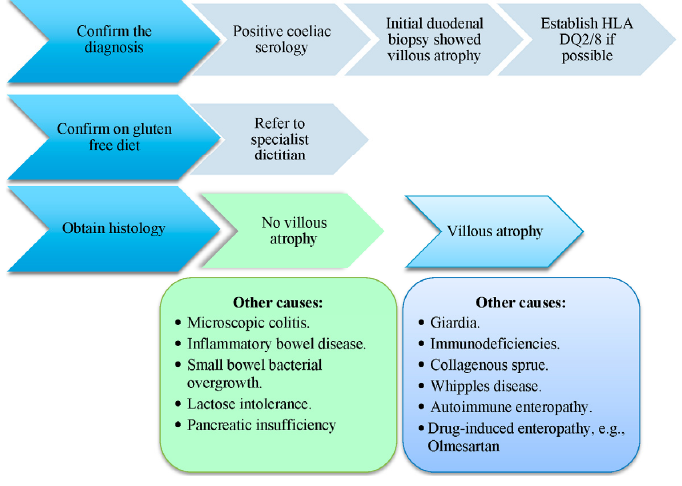
Figure 3. Approach to investigating non ‐ responsive coeliac disease.